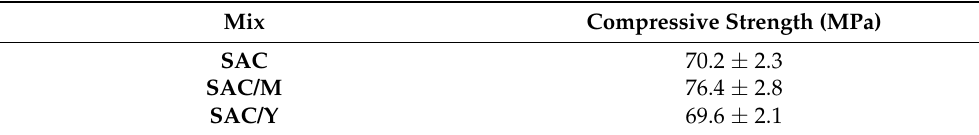
Table 8. Compressive strength on 75 × 150 mm cores (mean value and standard deviation).